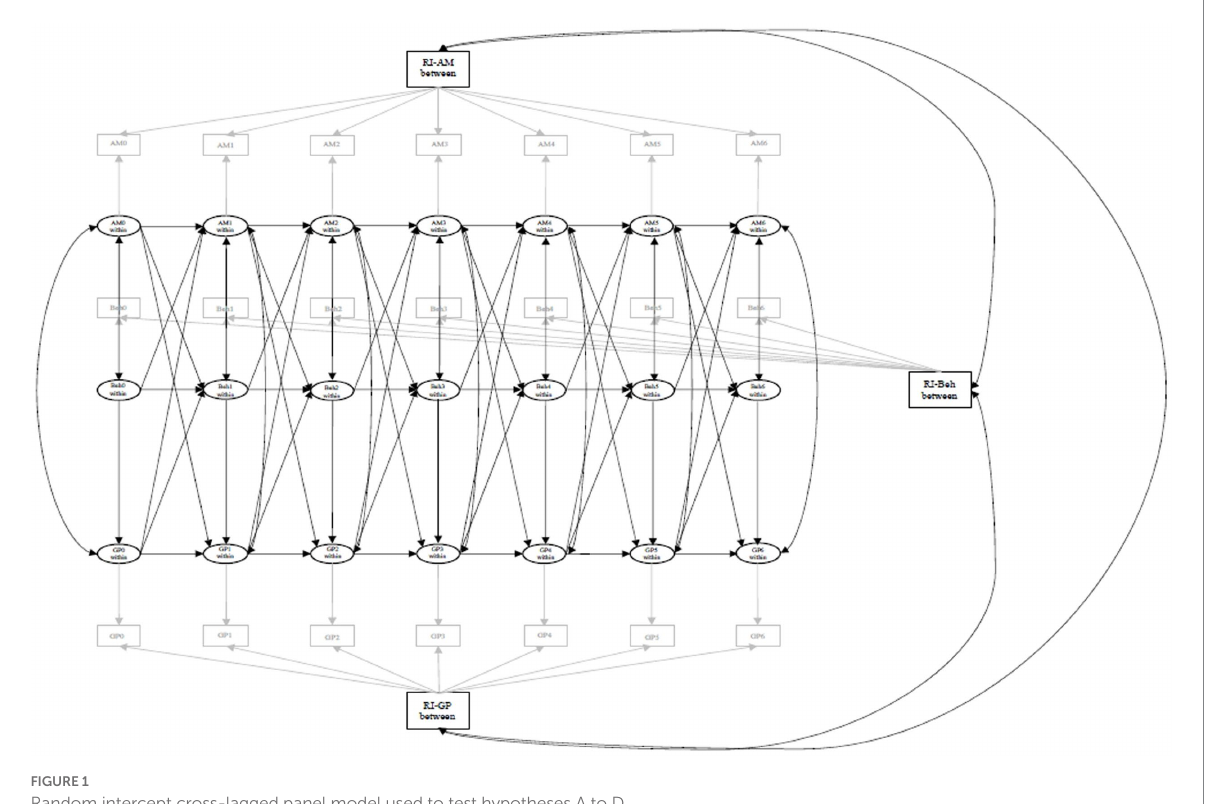
FIGURE 1 Random intercept cross-lagged panel model used to test hypotheses A to D.